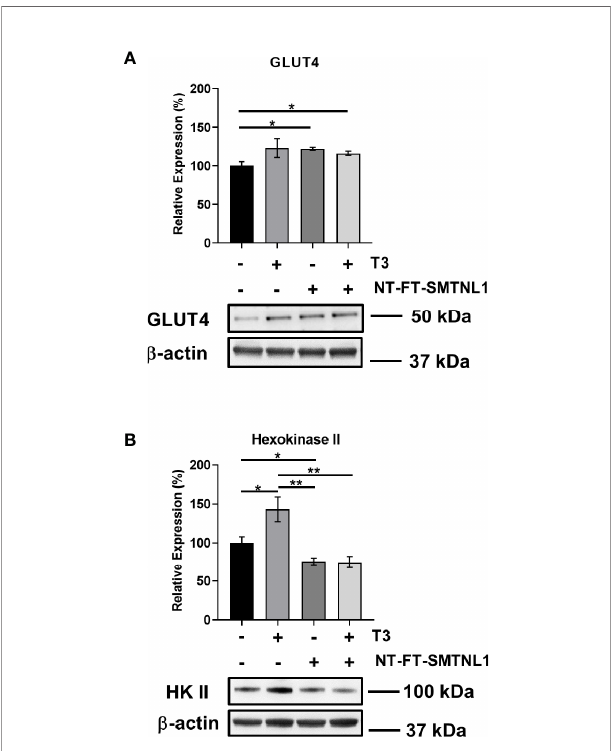
FIGURE 8 | T3 treatment and SMTNL1 overexpression affect the expression of crucial members of glucose metabolism. Myoblasts were transfected with empty vector or NT-FT-SMTNL1 and were differentiated with a 72-hour T3 treatment starting from Day 4. Proteins from whole-cell lysates were analyzed by Western blot using anti-GLUT4 (A) and anti-hexokinase II (B) antibodies. Values represent n=3-4, mean +/- SEM. Data were normalized to the empty vector-transfected control. Groups were compared using One-way ANOVA and Tukey ’ s post hoc test, p < 0.05 (*), p < 0.01